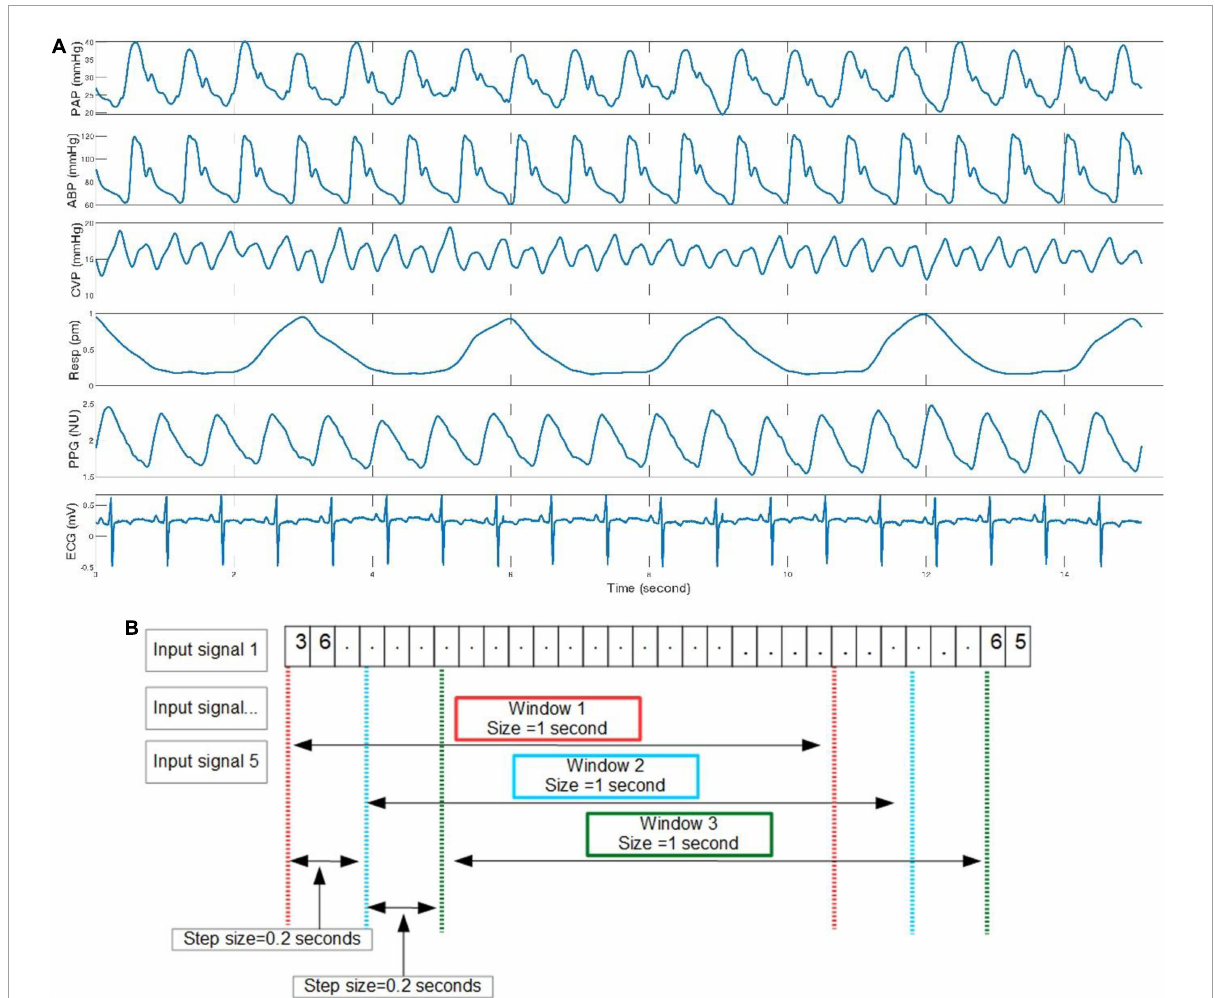
FIGURE2 Demonstration of six signals and segmentation method. (A) ABP, CVP, respiration, PPG, and ECG are input predictors, and PAP is the outcome variable. (B) The sliding window method was adopted in this study to generate input samples.